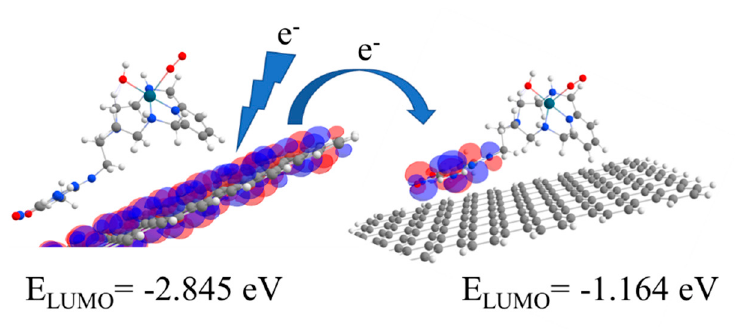
Figure 5. Scheme representing the ORR process on a functionalized carbon nanotube.